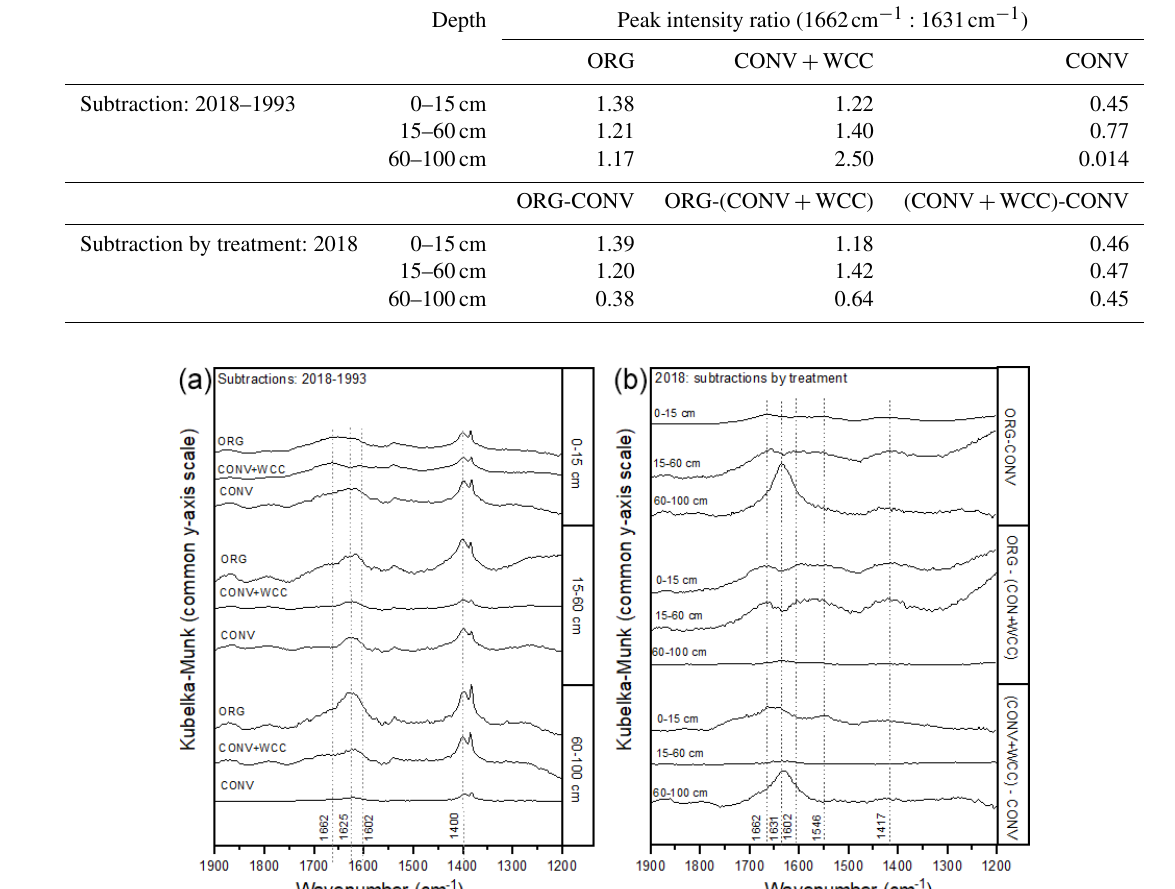
Table 1. Peak intensity ratios for aromatic (1662cm − 1 ) to asymmetric carboxyl (1631cm − 1 ) groups in spectral subtractions.